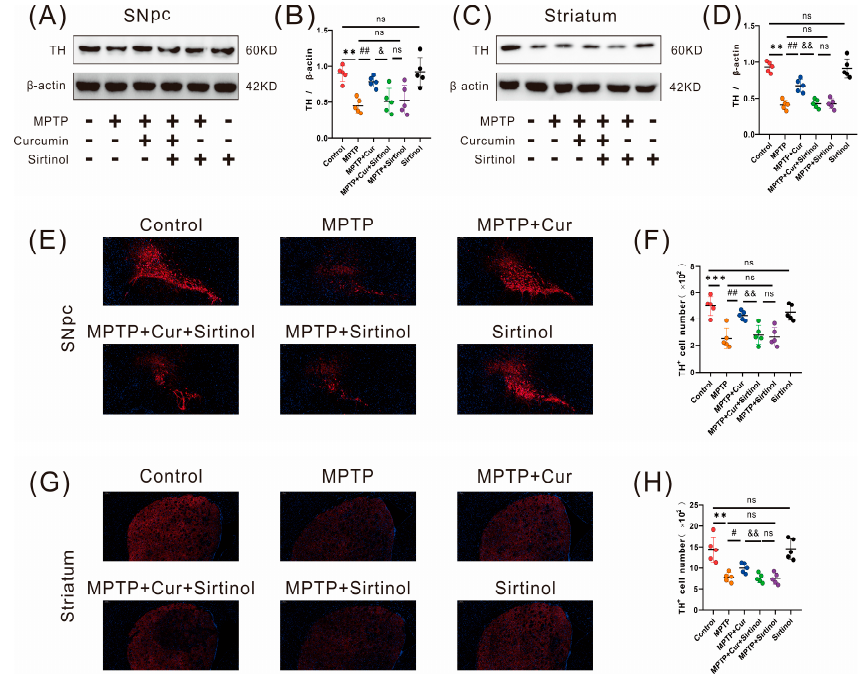
Figure 10 . The neuroprotective effect of curcumin was dependent on the gut–brain axis. ( A − D ) Quantification of the TH expression in the SN and striatum using Western blot in the six groups; ( E , G ) representative immunofluorescence images of TH—positive cells in the SN and striatum of the six groups; ( F , H ) Quantitative analysis of TH—positive regions in the SN and striatum in the six groups ( n = 5). The quantitative analysis of the TH—positive regions was performed using ImageJ. All statistical differences were tested using the t -test ( B , D , F , H ). Data are expressed as the mean ± SEM ( n = 5/group). Representative results are for one of the independent experiments. ** p < 0.01 and *** p < 0.001 vs. control group. # p < 0.05 and ## p < 0.01 vs. MPTP group. & p < 0.05,&& p < 0.01 vs. MPTP+Cur group. n.s., not significant.